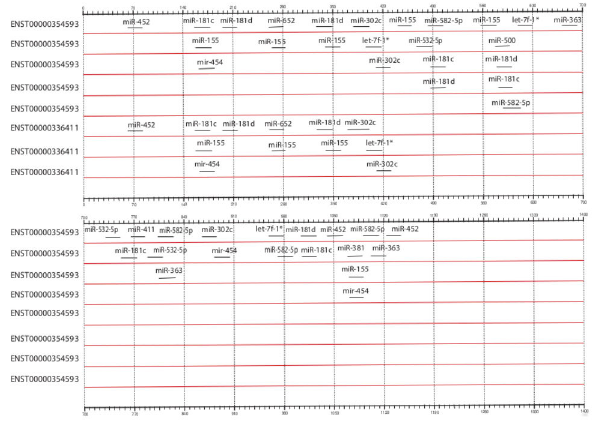
Table S1. List of miRNA target sites for CYP3A4 gene.The binding locations of the miRNAs are shown with respect to the UTR co-ordinates of the respective